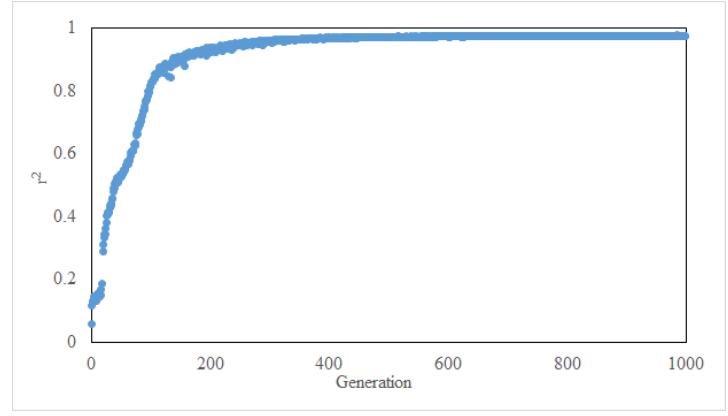
Figure 6. Fitness of CNN model in each evolutionary step.